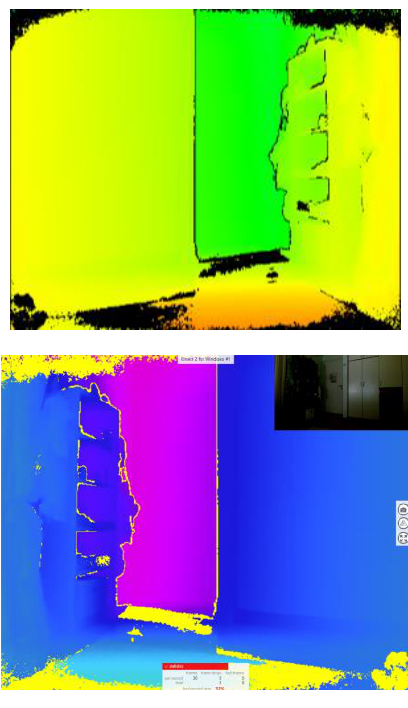
Figure 6: The same background displayed in Kinect Studio (top) and iPi Recorder